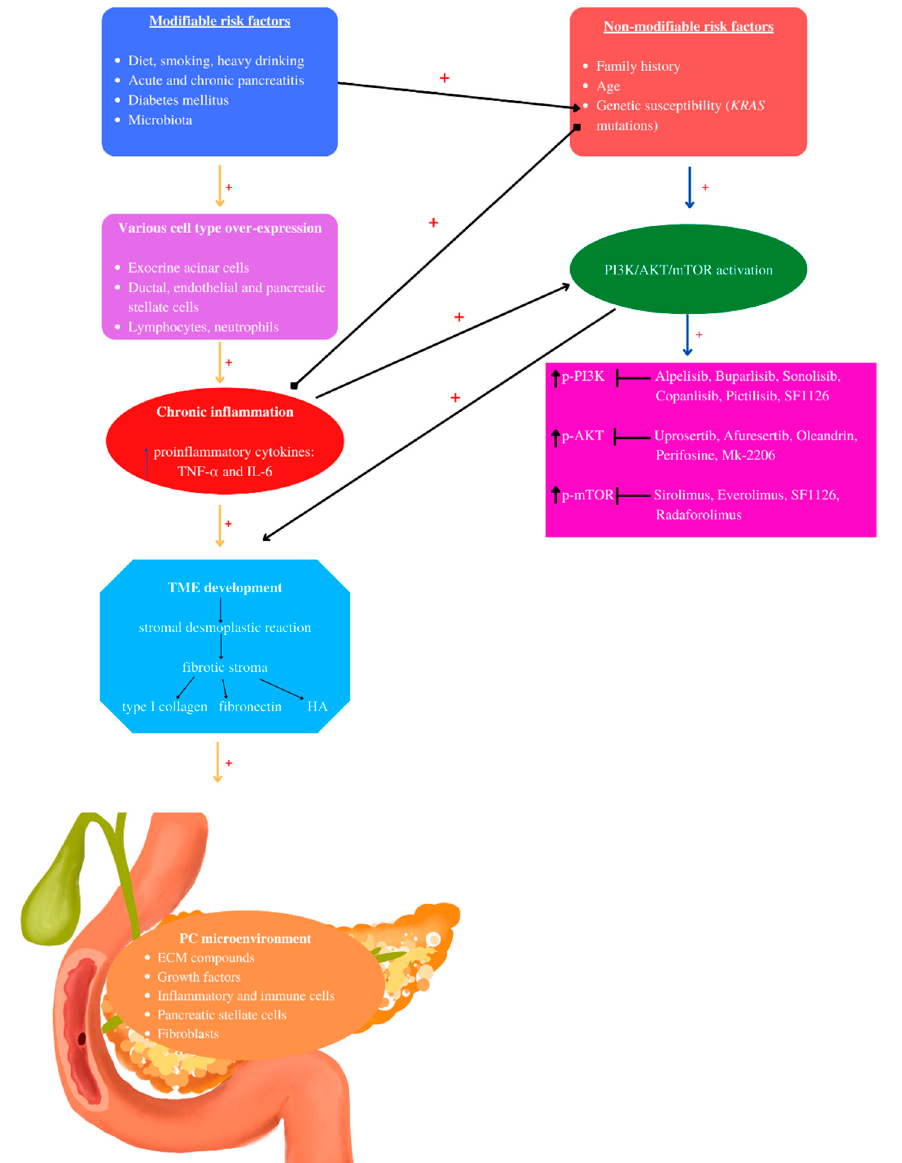
Figure 3. Pancreatic cancer pathogenesis: The pathogenesis of PC involves non- and mod- ifiable risk factors that induce chronic inflammation mediated by several cell types. risk factors that induce chronic inflammation mediated by several cell types. Chronic inflamma- tion mediates TME development characterized by stromal desmoplastic reaction—the main PC histological hallmark, leading to fibrotic stoma formation, rich in type I collagen, fibronectin, and hyaluronic acid (HA). KRAS mutations may be activated by inflammation and modifiable risk factors such as diet and diabetes mellitus. Chronic inflammation and KRAS mutations are the main actors that induce PI3K/AKT/mTOR activation, contributing to PC-TME development, correlated with increased phosphorylated levels. Currently, the mentioned PI3K/AKT/mTOR inhibitors have been used in clinical studies. “+”